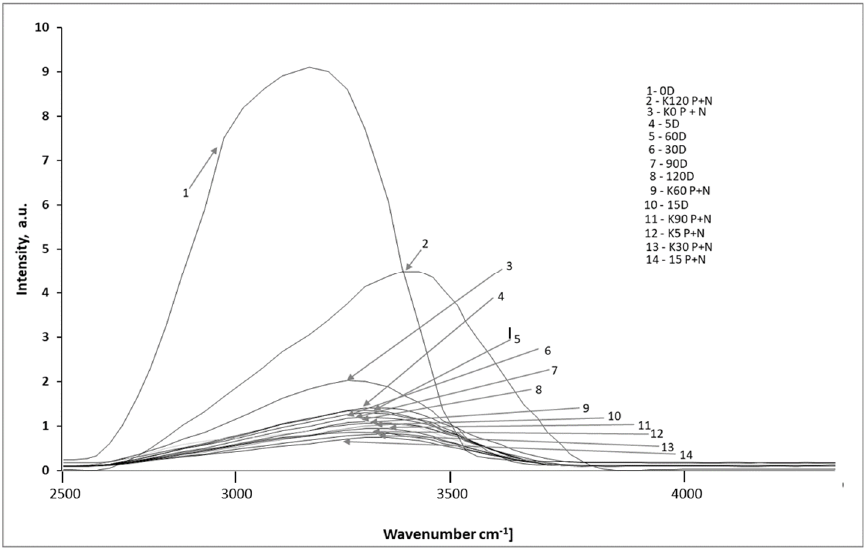
Figure 11. Raman spectra of deionized and tap WTS.